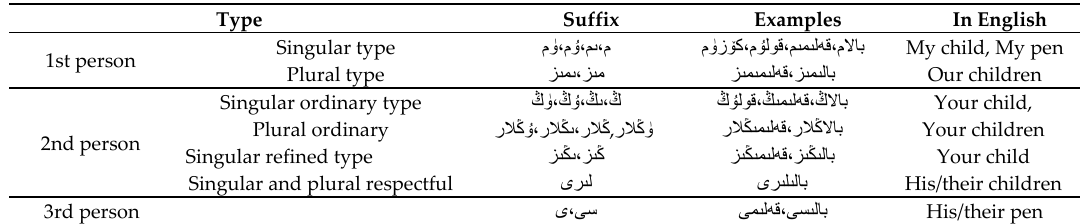
Table 1. Suffixes of the ownership category.